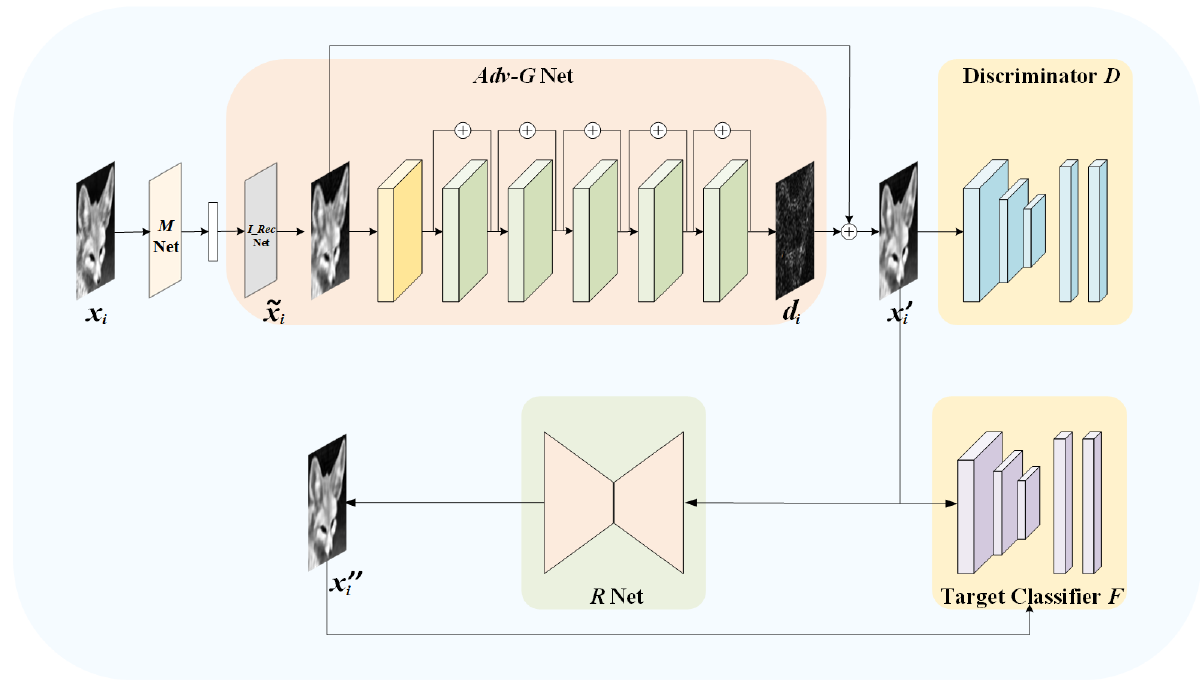
Figure 2. Architecture of the IPPARNet.